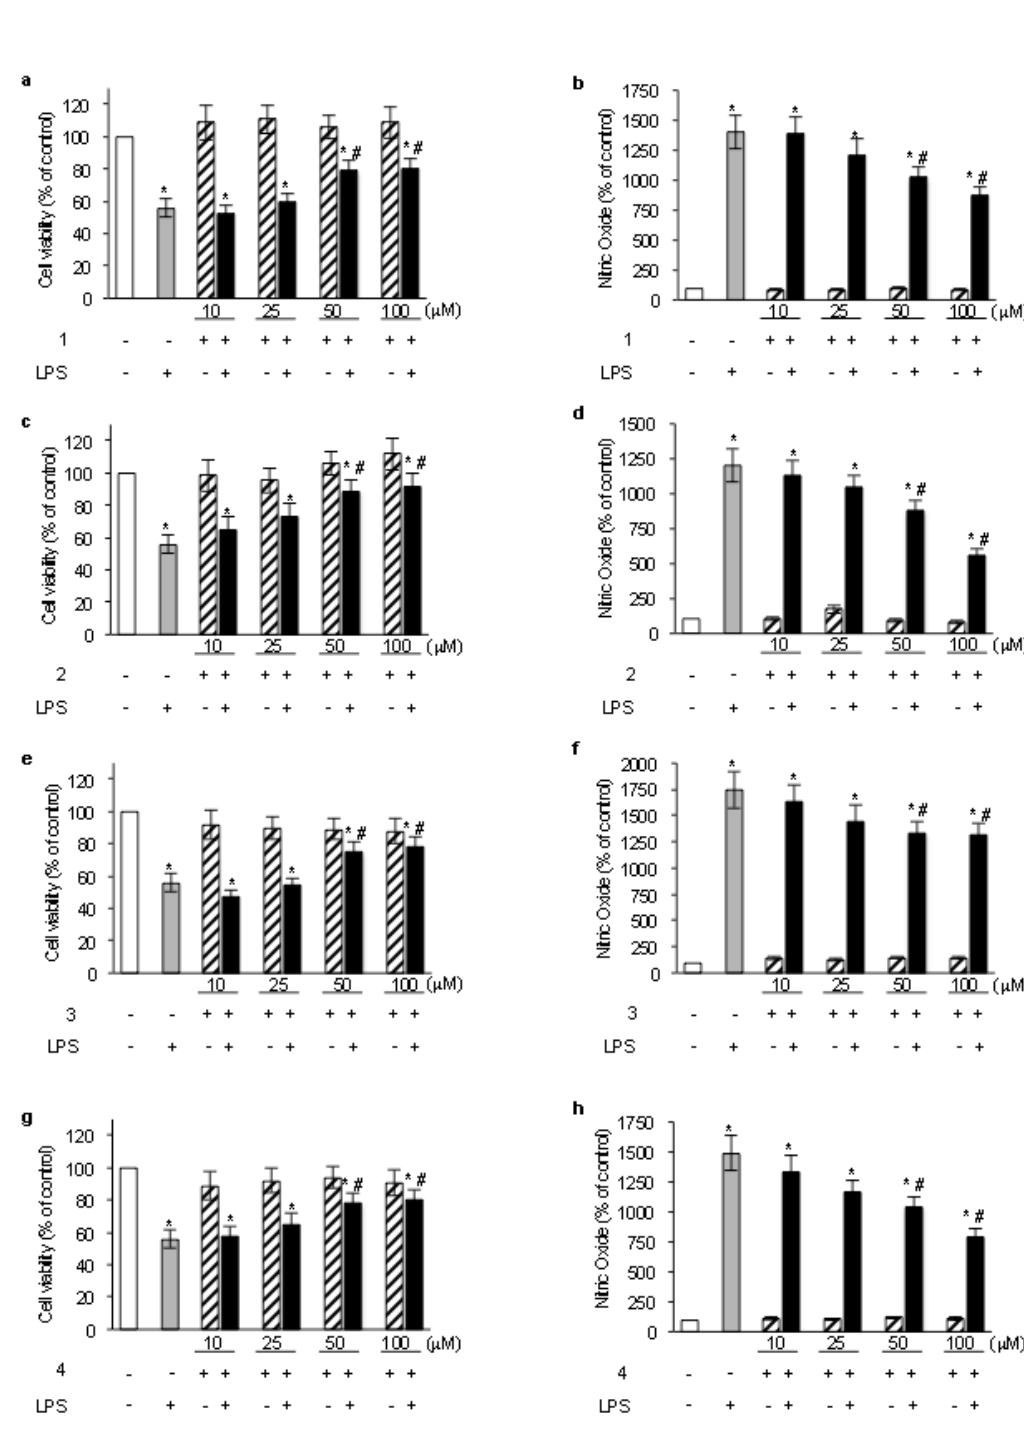
Figure 2. The compounds reduced LPS-induced NO generation and protected microglial cells from LPS-induced cytotoxicity. BV-2 microglial cells were treated for 24 h with the tested compounds (50  M), then stimulated with 10  g/mL LPS for further 24 h and used to assess cell viability (a, c, e and g) and NO levels (b, d, f and h). Control values (mean ± S.D., n = 4) are given as 100% * p < 0.05 vs. control cells; # p < 0.05 vs. LPS-treated